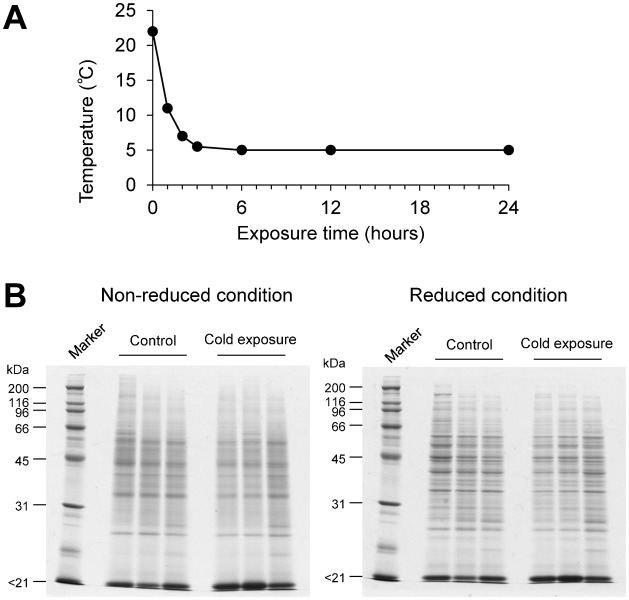
Transitions in environmental temperature and hepatic proteins.(A) Relationship between cold-exposure time and water temperature. A plastic tank containing 1 l of 22°C water was transferred to an incubator at 5°C and allowed to cool. During that time, the temperature of the water was measured. (B) Image of SDS-PAGE gels used to separate X. laevis liver protein samples; 10 µg of each sample from either the control or cold-exposure group (three frogs each) was separated on 12% SDS polyacrylamide gels. Protein bands were visualized by staining with Coomassie brilliant blue R-250. Reducing (right panel) and non-reducing (left panel) conditions are shown.